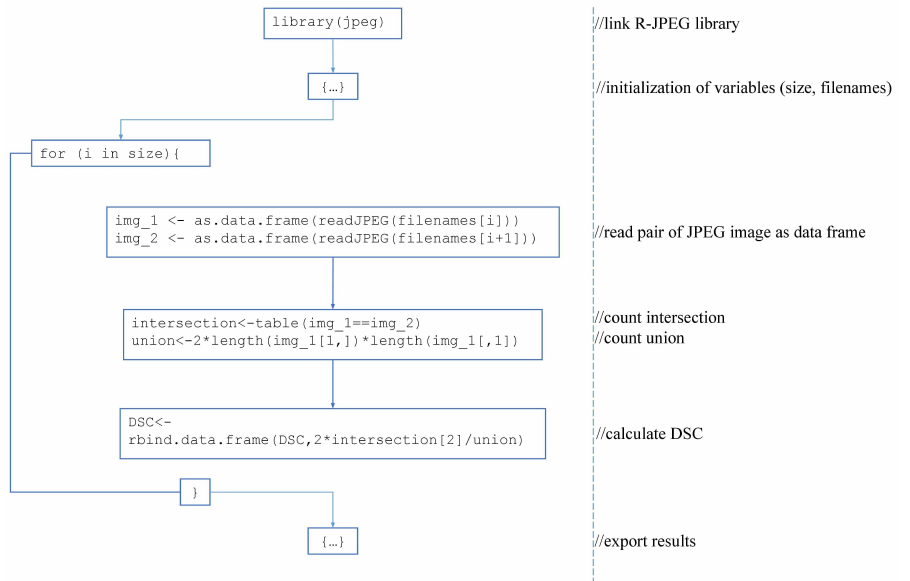
Figure 1. Scheme of R script for DSC calculation with comments.